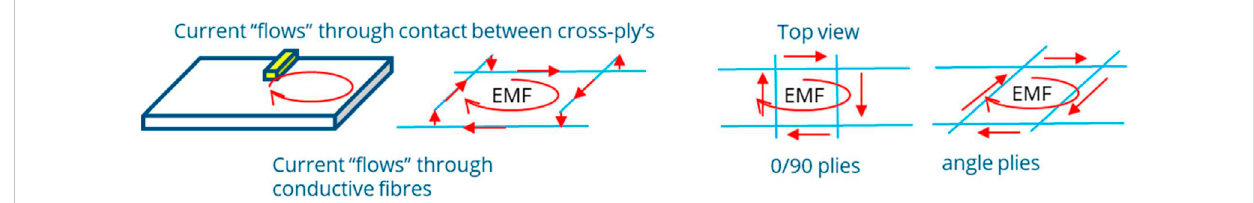
FIGURE 1 Cross-plies form a closed loop such that current can ‘ fl ow ’ through the plies. EMF stands for electromagnetic fi eld.